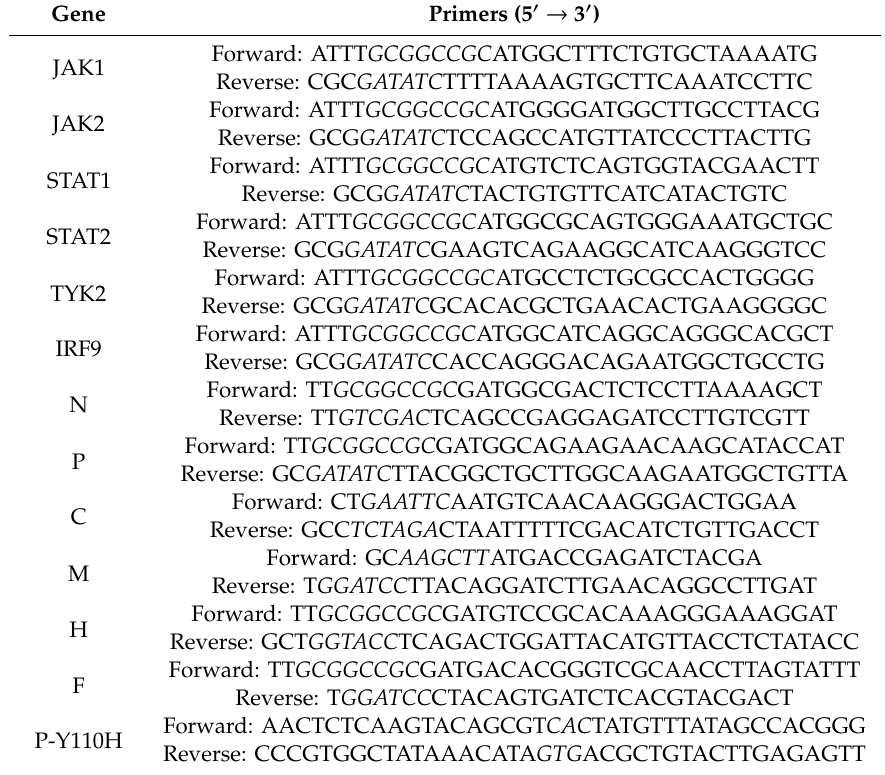
Table 1. The primers used for plasmids construction.